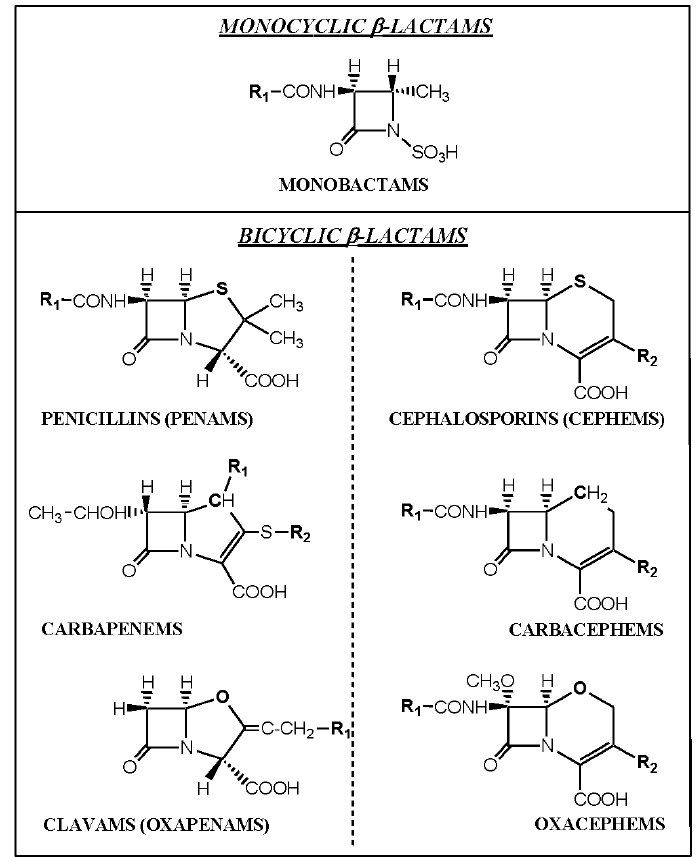
Figure 4. Structures of the four main groups of β -lactam antibacterials, penams (penicillins), cephems (cephalosporins), monobactams (e.g., aztreonam) and carbapenems (imipenem, meropenem). Other less often used groups of β -lactams are the carbacephems (loracarbef), clavams (clavulanic acid), oxacephems (moxalactam) and (not shown) cephamycins (cefmetazole, cefotetan,